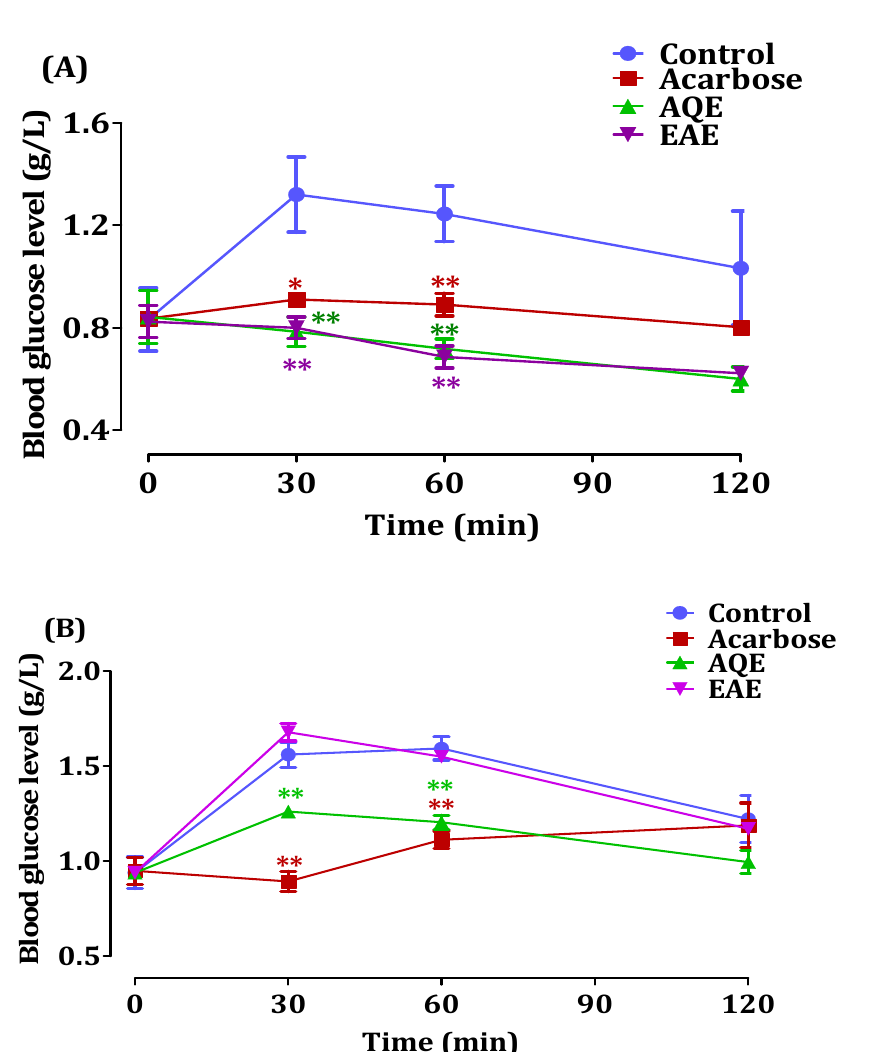
Figure 7. The effect A. absinthium extracts and acarbose on glycemia in diabetic rats after starch overload ( A ), and after sucrose overload ( B ) ( n = 5) ((* p < 0.05) and (** p <